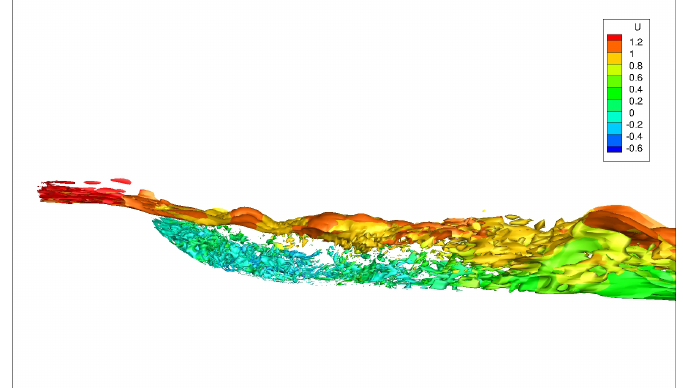
Figure 9. Instantaneous iso-surface of vorticity